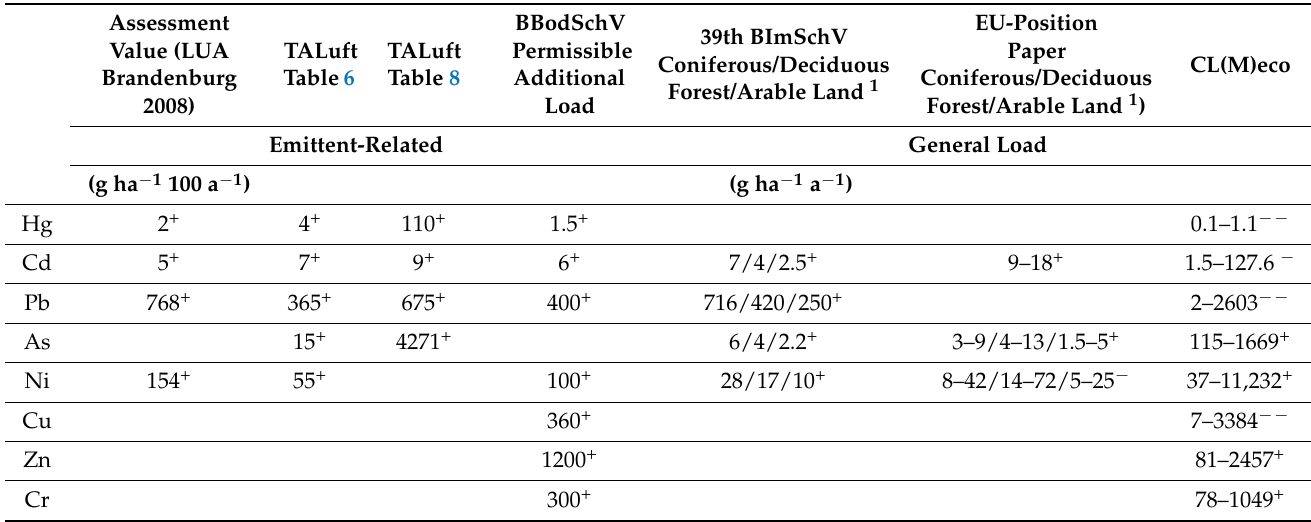
Table 17. Assessment values for heavy metal fluxes to protect ecosystems and their exceedance/undercutting by atmospheric deposition (for Hg: EMEP in 2013 [10,11]; for all others German dataset in 2010